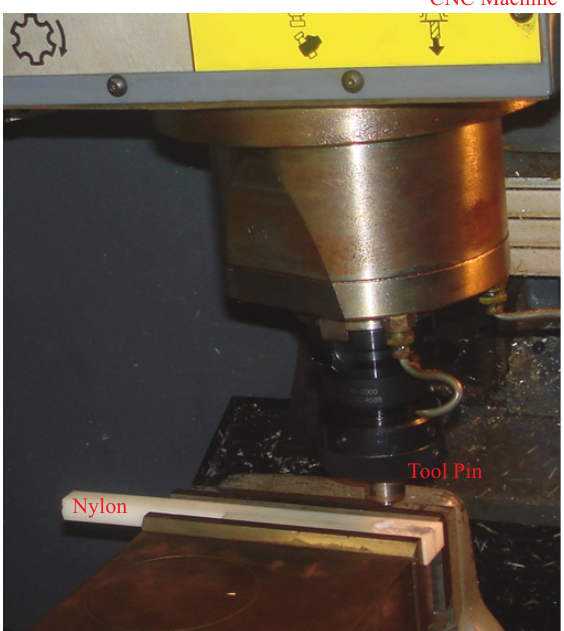
Figure 12 . Equipment for friction stir processing polymer